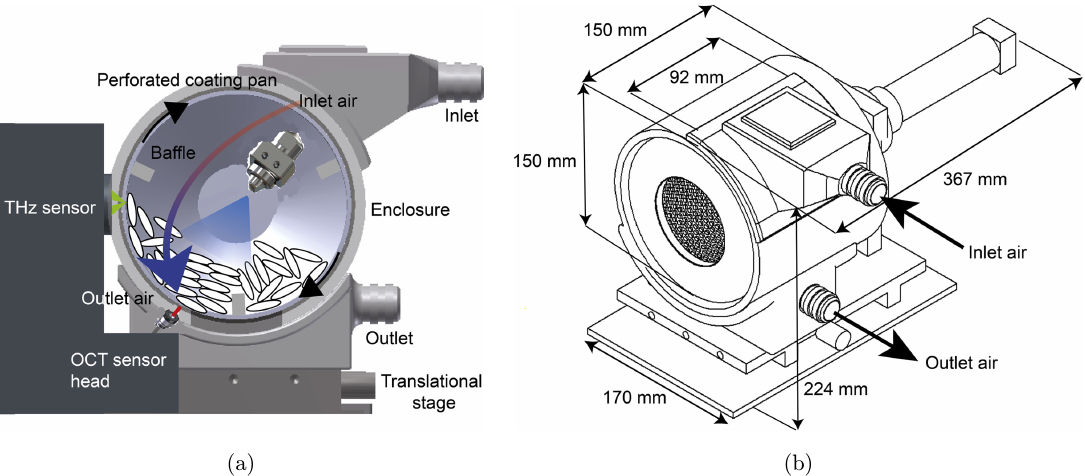
Fig. 6. (a) Schematic diagram of the scale pan coater coupled to the TPI measurement and (b) A technical drawing of the pan coater in perspective view. Reproduced from Ref.